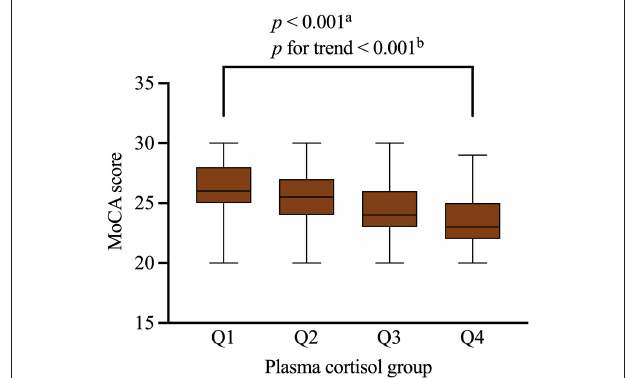
FIGURE 3 | MoCA scores of the participants with different quartiles of serum cortisol levels. Serum cortisol levels were closely related to cognitive impairment in the participants. Serum cortisol quartiles in the subjects were: Q1 < 10.3 ug/dL, Q2 = 10.3–13.6 ug/dL, Q3 = 13.6–15.0 ug/dL, Q4 ≥ 15.0 ug/dL. Boxplot elements: center line represents the median, box bounds represent the 25th and 75th percentile, and whiskers represent minimum and maximum respectively. MoCA, Montreal Cognitive Assessment. a Kruskal-Wallis test. b Jonckheere-Terpstra